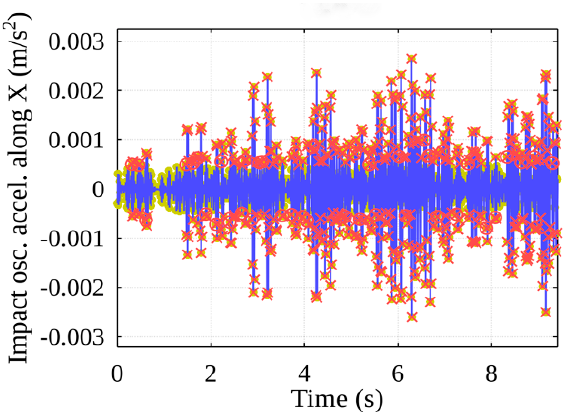
Figure 23. The possible impacts were detected from data of acceleration along the X-axis. In addition, as the filter frequency increases (see Figure 24), the graph shows a sudden jump in the number of recorded events (looking at the extremes) at the beginning of the filter frequency range, and from 2.5 Hz the change stabilizes and becomes linear. This